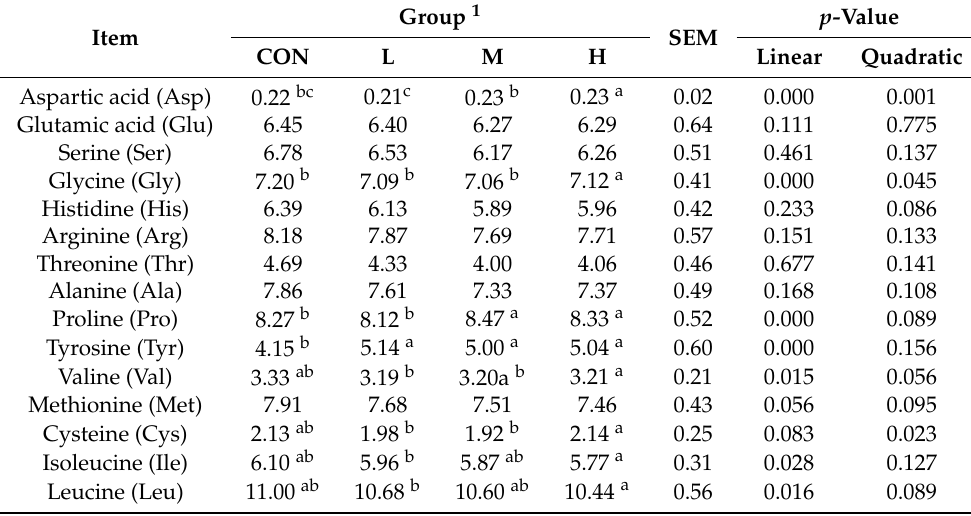
Table 7. Effects on amino acid profiles in longissimus dorsi muscles of Hu lambs by substituting 0 (CON group), 20 (L group), 40 (M group), and 60% (H group) of maize silage with mulberry silage (% of total amino